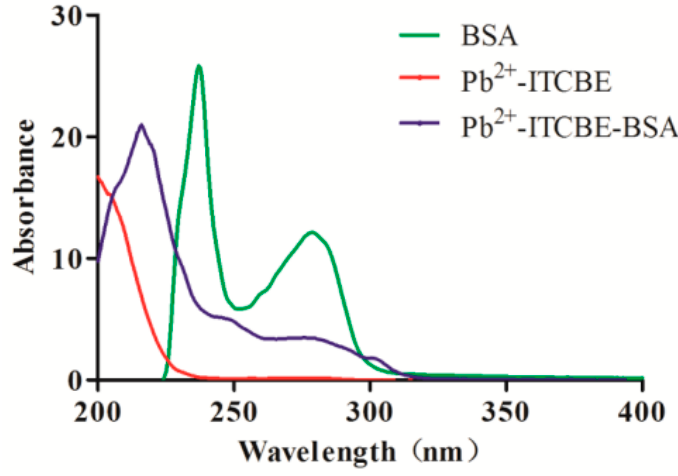
Figure 1. UV absorbance spectra of lead (II)-ITCBE, BSA and lead (II)-ITCBE-BSA.